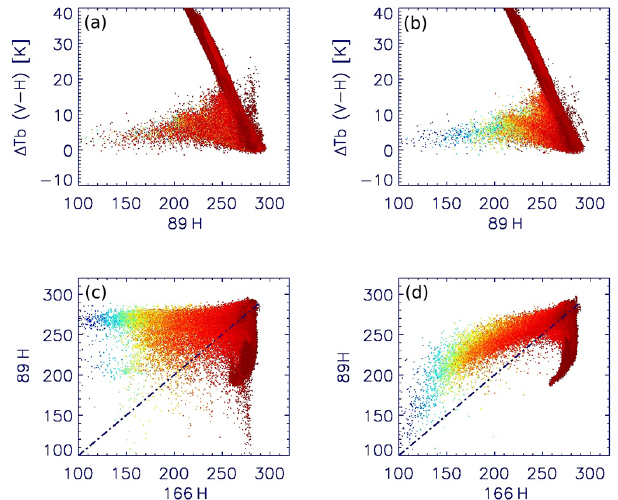
Figure A1. Scatter plots of 1-day tropical oceanic radiance mea- surements from the L1B (a, c) and L1C-R (b, d) datasets, showing poorly (L1B) and correctly (L1C-R) georegistered radiance data. Points are color-coded by the 183.3 ± 3GHz radiance values, with red being warm and blue being